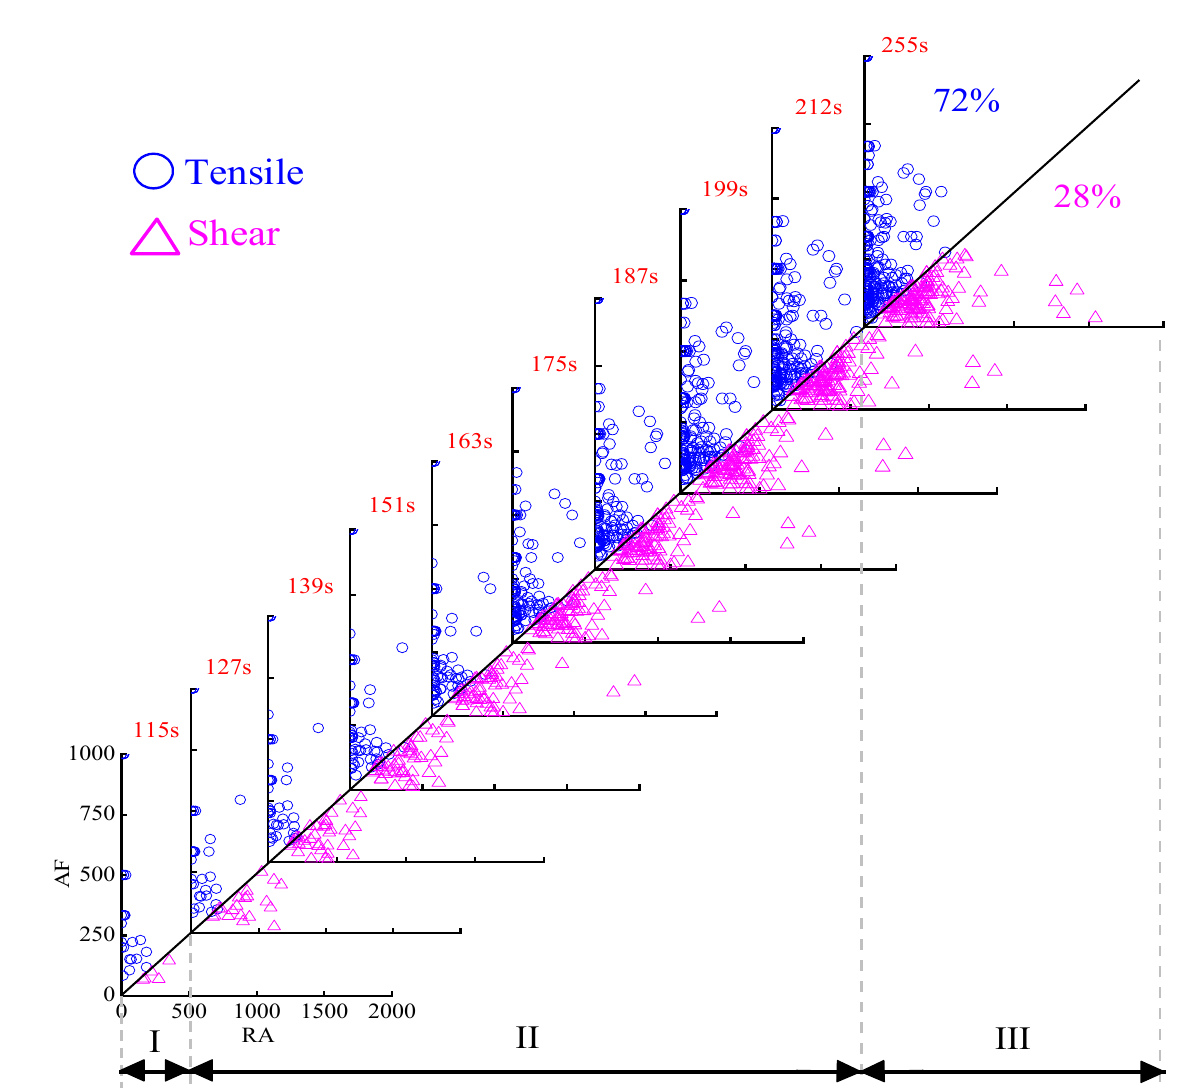
Figure 13. RA and AF distribution of BFAC.